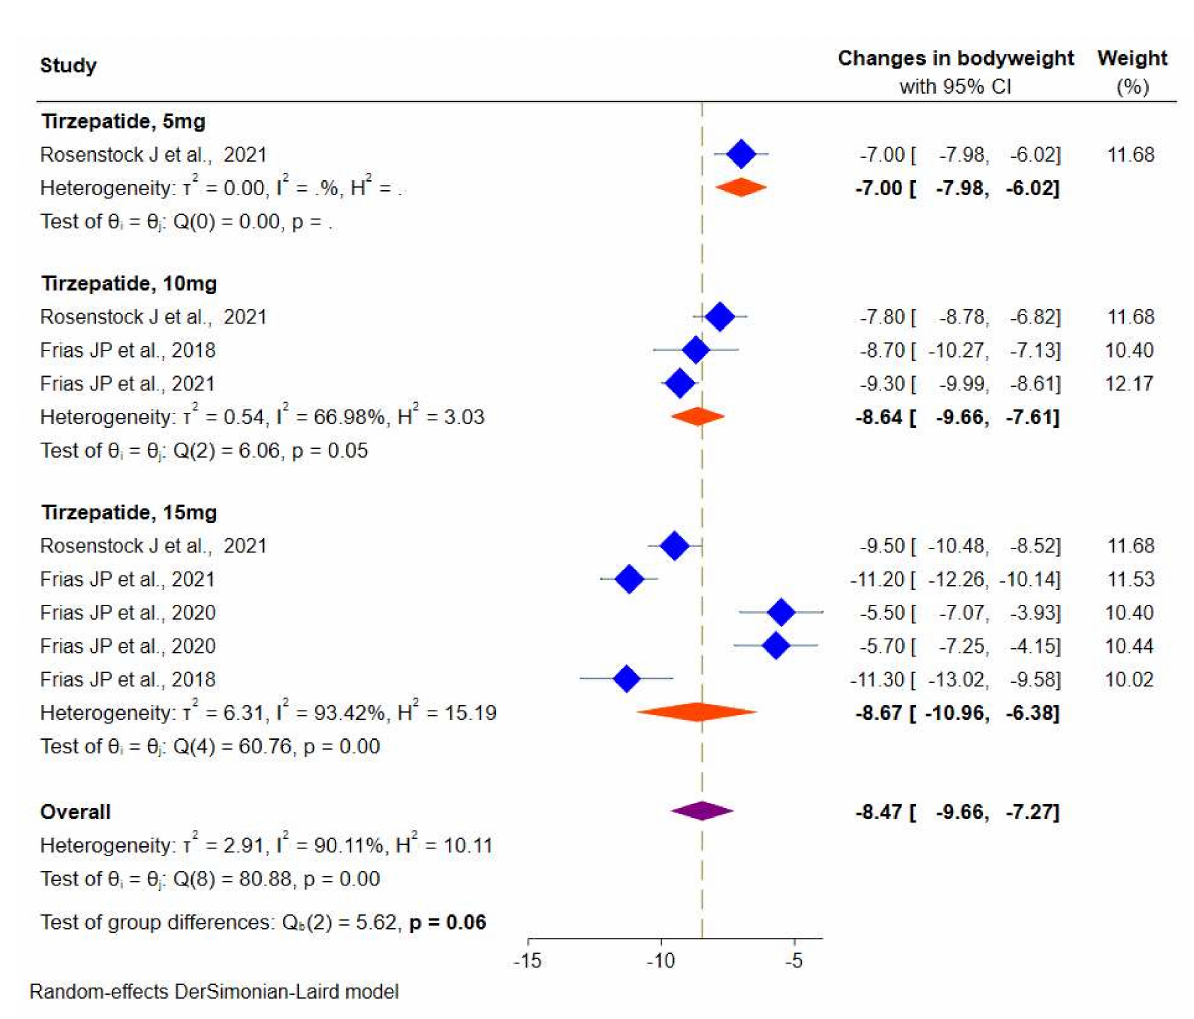
Figure 6. Effect of once-weekly tirzepatide on body weight (kg). Table 2. Safety of